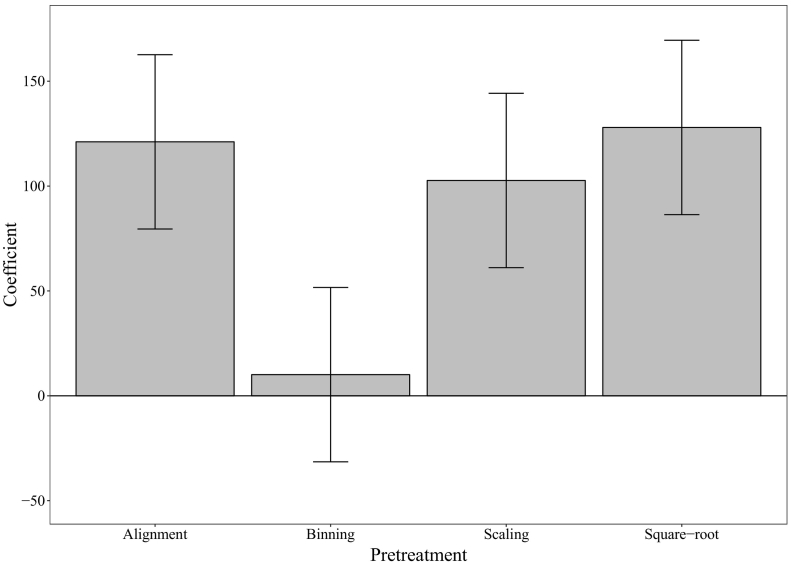
Multiple regression coefficients used as a measure of pre-treatment effects on F (Section 2.5).